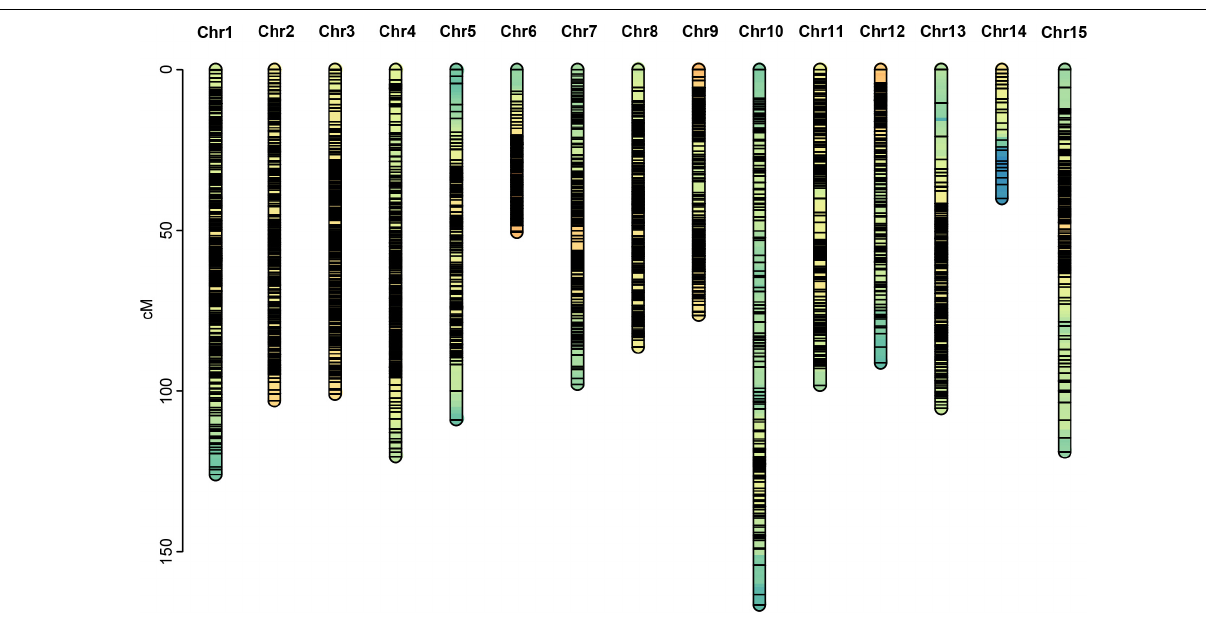
FIGURE 3 | Genetic map constructed in this